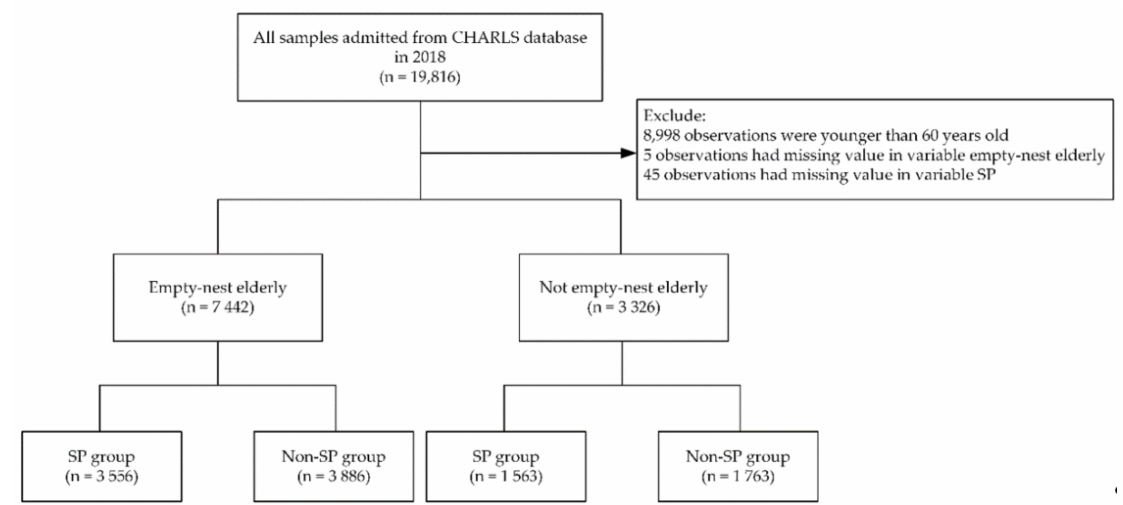
Figure 1. Selection of study participants. The n stands for the observations. CHARLS, China Health and Retirement Longitudinal Study; SP, social